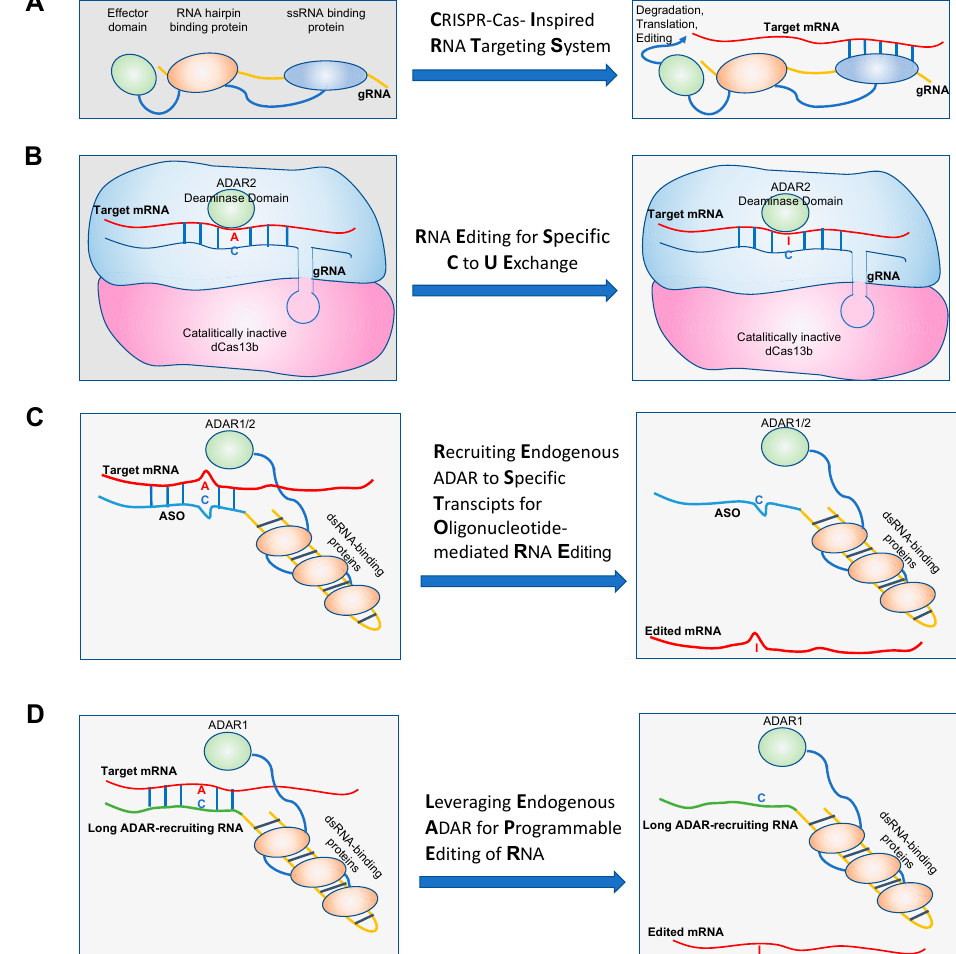
Figure 2. Schematic representation of ( A ) CIRTS, ( B ) RESCUE, ( C ) RESTORE, and ( D ) LEAPER RNA editing approaches.